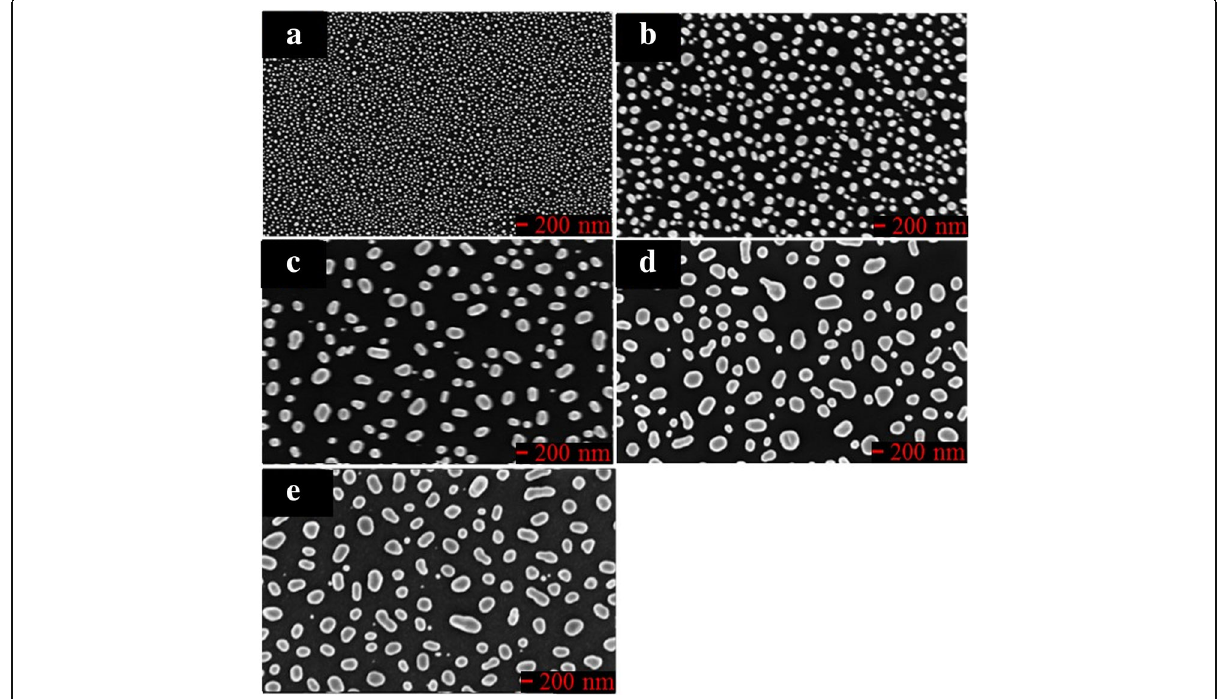
Fig. 1 Top-view SEM images of Au particles on surfaces with different mean particle diameters and spacing: a (d, s) = (45 nm, 40 nm); b (d, s) = (105 nm, 85 nm); c (d, s) = (150 nm, 125 nm); d (d, s) = (180 nm, 150 nm); e (d, s) = (200 nm, 170